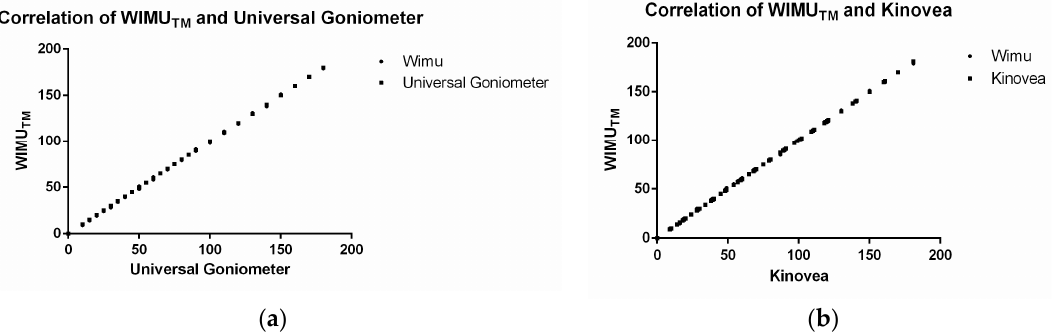
Figure 3. Agreement between Universal Goniometer (UG), Kinovea software, and WIMU TM measurements, based on the measurement of different angles ( n = 88) in Phase 1. ( a ) correlation of WIMU TM and universal goniometer; ( b ) correlation of WIMU TM and kinovea